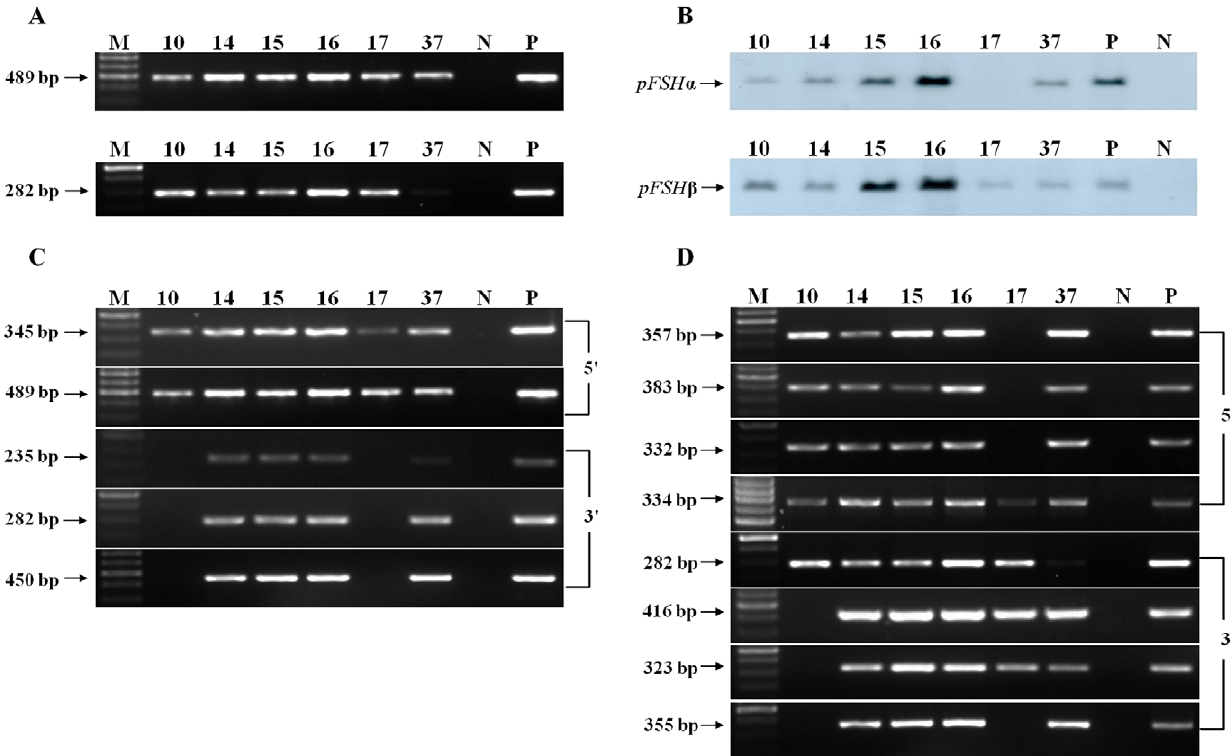
Figure 2. Identification of TG mice and assessment of the integrity of BAC transgenes in TG mice. (A) PCR for detecting TG mice. Two pairs of primers were used to amplify the 489 bp and 282 bp inserts. M, 100 bp DNA ladder; 10–37, TG founders; N, genomic DNA from WT mouse as a negative control; P, circular BAC DNA as a positive control. (B) Southern blot analysis of integrated pFSH transgenes. Purified genomic DNA (10 m g) from each TG founder was digested by Bam HI overnight at 37 u C and analyzed by Southern blotting using probes specific for pFSH a and pFSH b . 10– 37, TG founders; P, porcine genomic DNA as positive control; N, genomic DNA from a WT mouse as a negative control. Band intensity was quantified by densitometry using Quantity-One software (Bio-Rad). (C–D) The two ends of both the BAC412H8 and BAC183O11 transgenes were amplified separately from TG mouse genomic DNA using 5 9 - or 3 9 -specific primers.